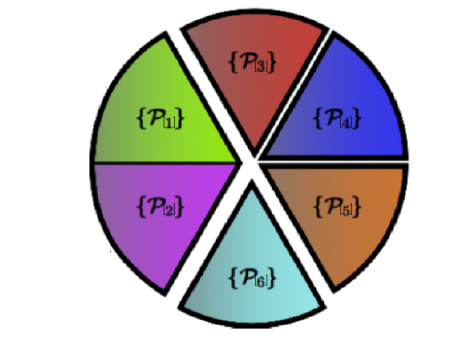
Figure 5 . f Z 2 (cid:2) Z 2 g partitioning of S 4